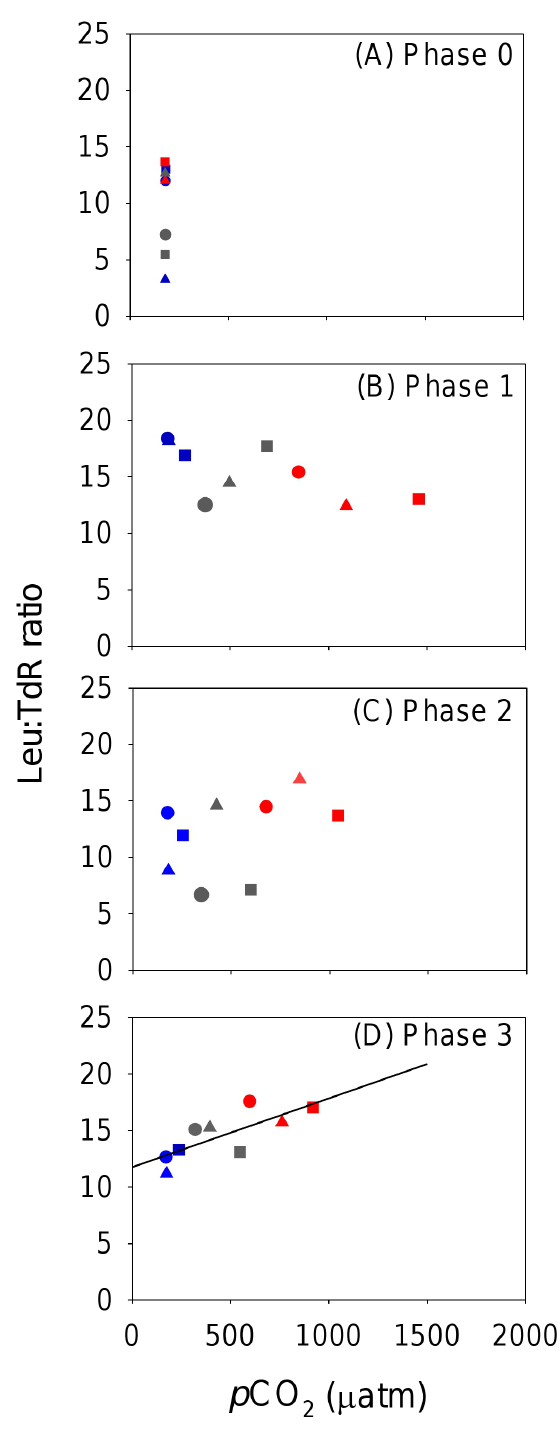
Fig. 7. Relationship between p CO 2 value and the Leu:TdR ratio in phase 0 (A) , phase 1 (B) , phase 2 (C) , and phase 3 (D) . Liner regression line in phase 3 (D) : Leu:TdR ratio=0.006 × p CO 2 + 11 . 7 (r 2 = 0 . 58, p < 0 . 05, n =